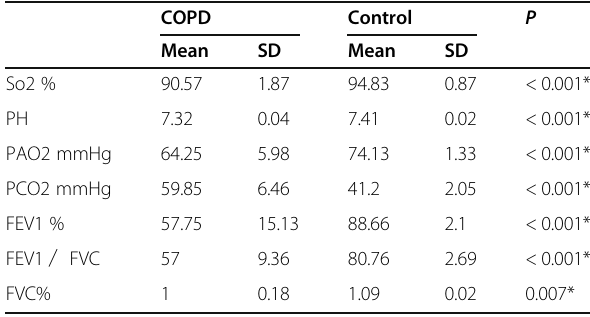
Table 1 Arterial blood gases and pulmonary function in